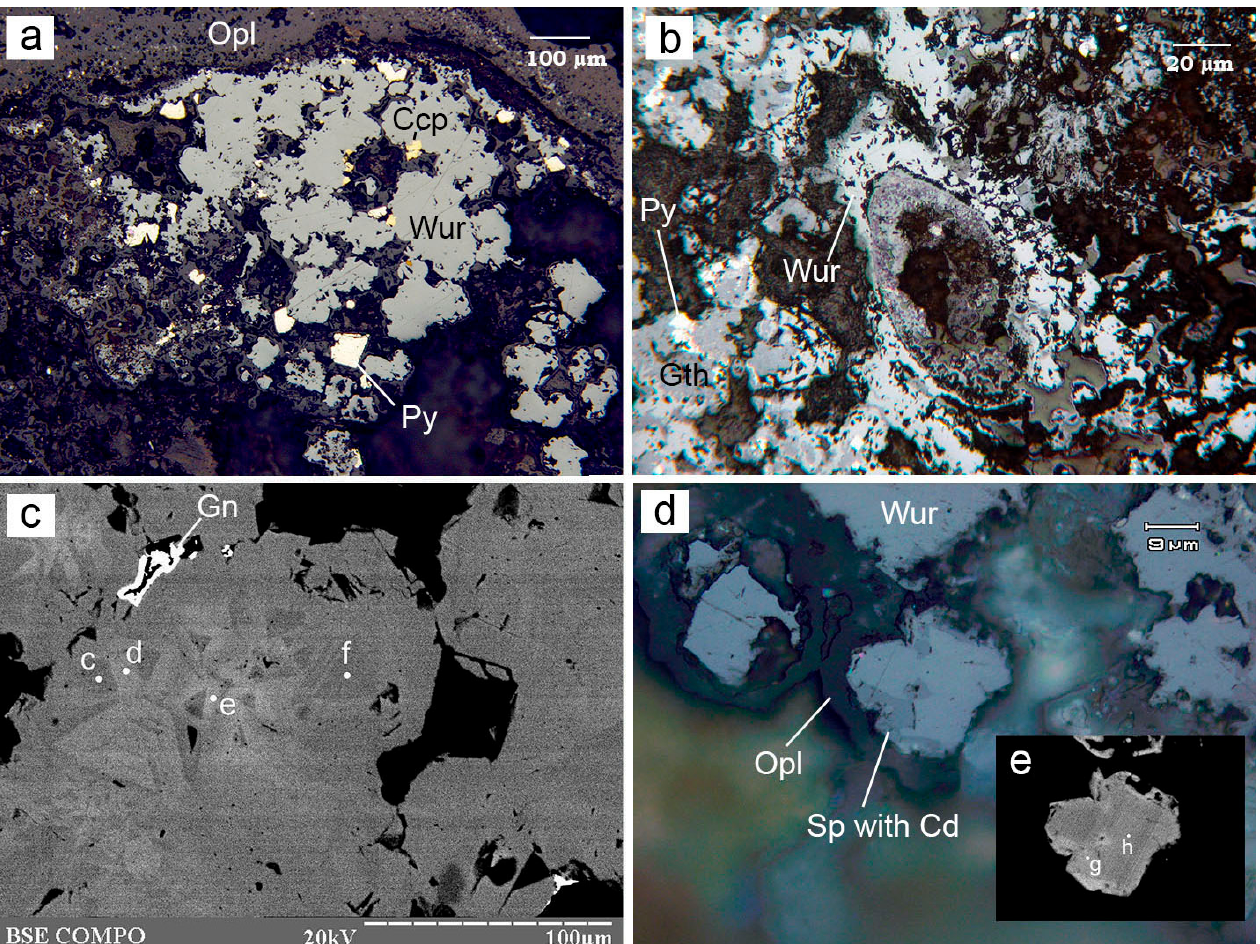
Figure 3. Morphology of wurtzite from the Irinovskoe HSF: ( a ) Crystalline wurtzite (Wur) among opal (Opl) with pyrite (Py) and chalcopyrite (Ccp) crystals on top; ( b ) Transverse section of a tube worm filled with Fe-oxyhydroxides (Gth) and overgrown by wurtzite; ( c ) Zoned–sectorial wurtzite crystals (SEM/EDS points (hereinafter, points) c–f) with high- and low-Fe zones overgrown by galena (Gn); ( d ) Wurtzite rimmed by opal and replaced by a Cd-bearing sphalerite (darker rim) with lower reflectivity; ( e ) Detail of the previous image: Fe-rich wurtzite (point h) replaced by a Cd-bearing sphalerite (point g). Images: reflected light ( a , b , d ); BSE ( c , e ). Sample numbers: 241-2/1-11 ( a , c – e ), 241-2/2-5 ( b ). Hereinafter, the mineral abbreviations follow the recommendations of Table 2. Selected chemical composition of Zn sulfides from the Irinovskoe HSF, wt%. Figure Analysis no.